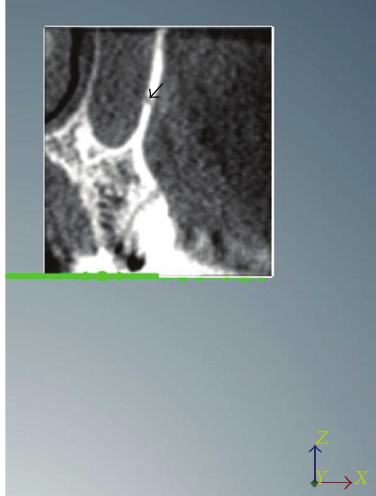
Figure 1: Coronal reconstruction showing the route of the bony canal (black arrow).